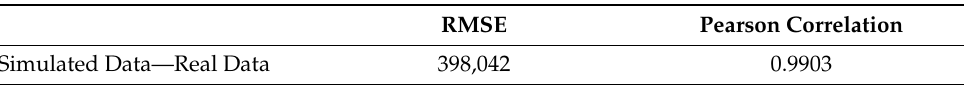
Figure 14. Positives’ daily representation—Lombardy region. Table 1. Pearson correlation and root mean squared error (RMSE) of our model with respect to the serological data